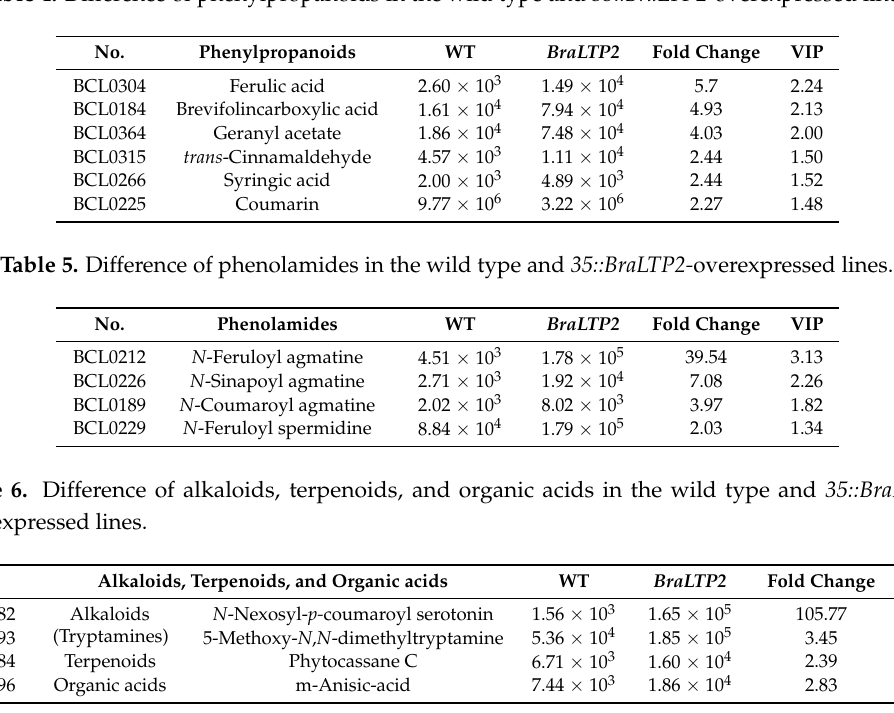
Table 7. Difference of other metabolites in the wild type and 35::BraLTP2- overexpressed lines.